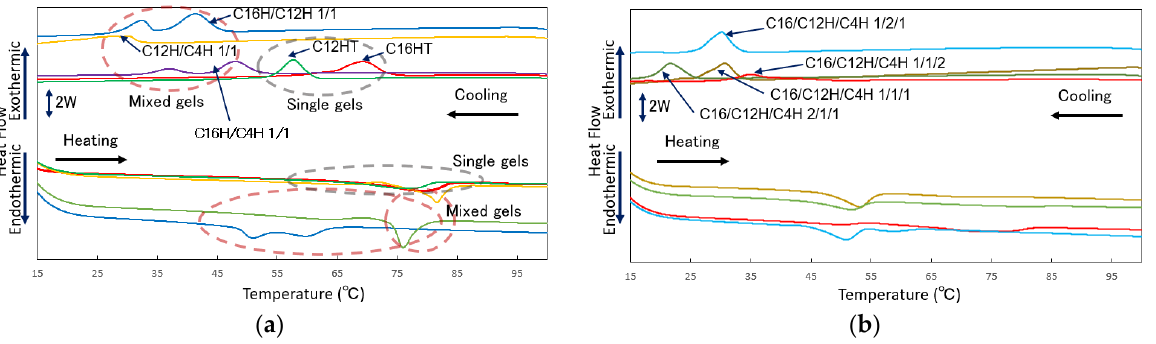
Figure 8. DSC curves of the mixed N -alkylhydantoin organogels. All samples are 3 wt.% squalane gels and mixed in a molar ratio (heating and cooling rate is 10 °C/min): ( a ) single and binary systems, ( b ) tertiary systems. Table 3. Transition temperatures of mixed N -alkylhydantoin organogels obtained by DSC measure- ments (heating and cooling rate is 10 ◦